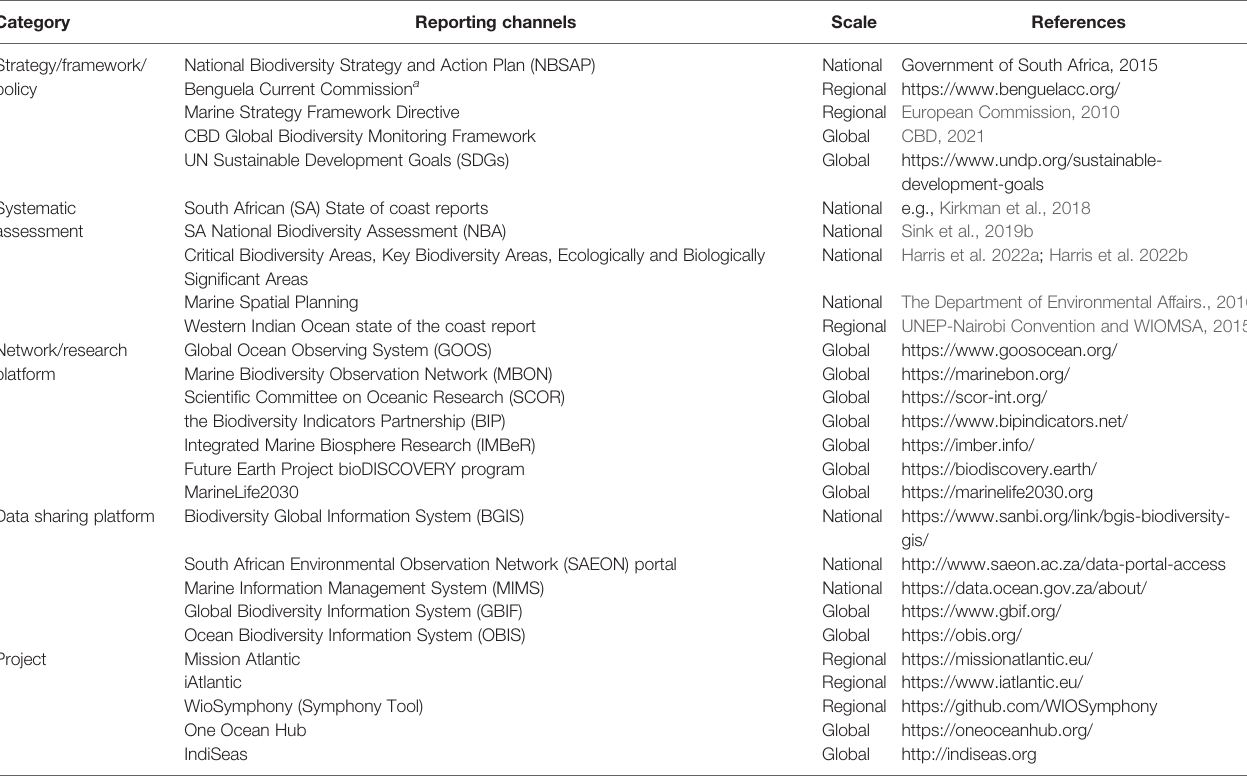
TABLE 1 | A concise list of marine-related frameworks and policies, integrated systemic assessments, networks, online data sharing platforms, and projects, relevant to marine biodiversity assessment in South Africa and that are commonly referred to in the